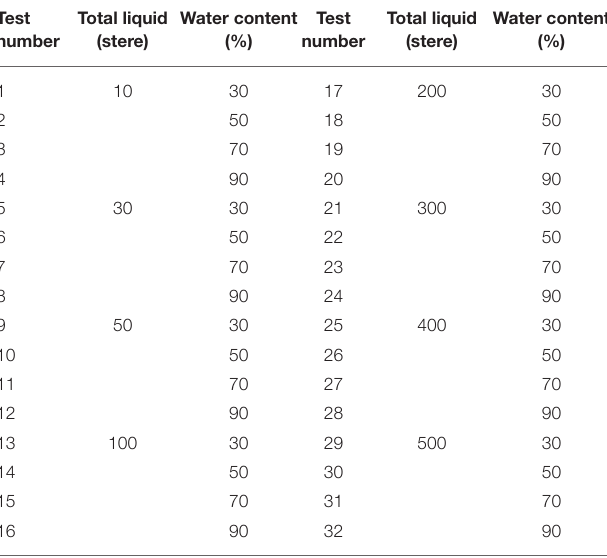
TABLE 1 | Measured liquid volume and water cut of oil–water two-phase flow experiments. Test Total liquid Water content Test Total liquid number (stere) (%) number